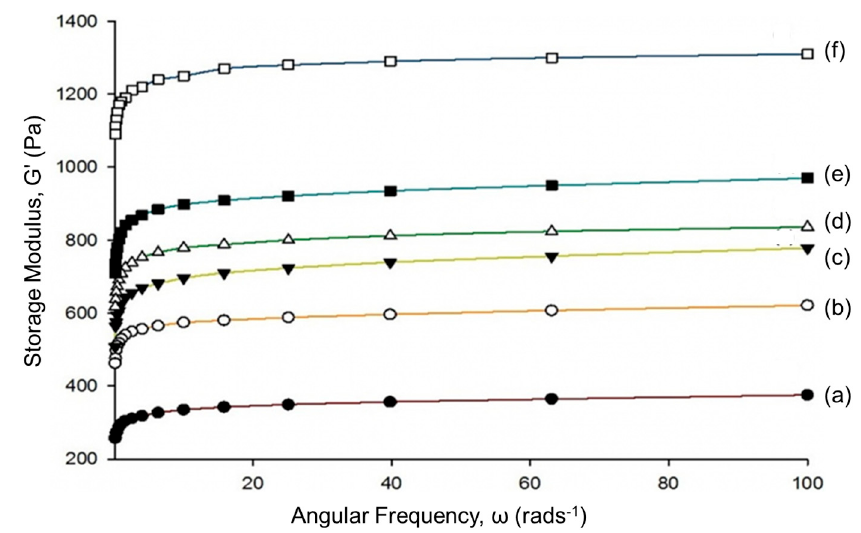
Figure 5. Storage moduli, G’ of ( a ) PAA hydrogel; ( b ) 5 wt % CNC/PAA hydrogel; ( c ) 10 wt % CNC/PAA hydrogel; ( d ) 15 wt % CNC/PAA hydrogel; ( e ) 20 wt % CNC/PAA hydrogel; and ( f ) 25 wt % CNC/PAA hydrogel.